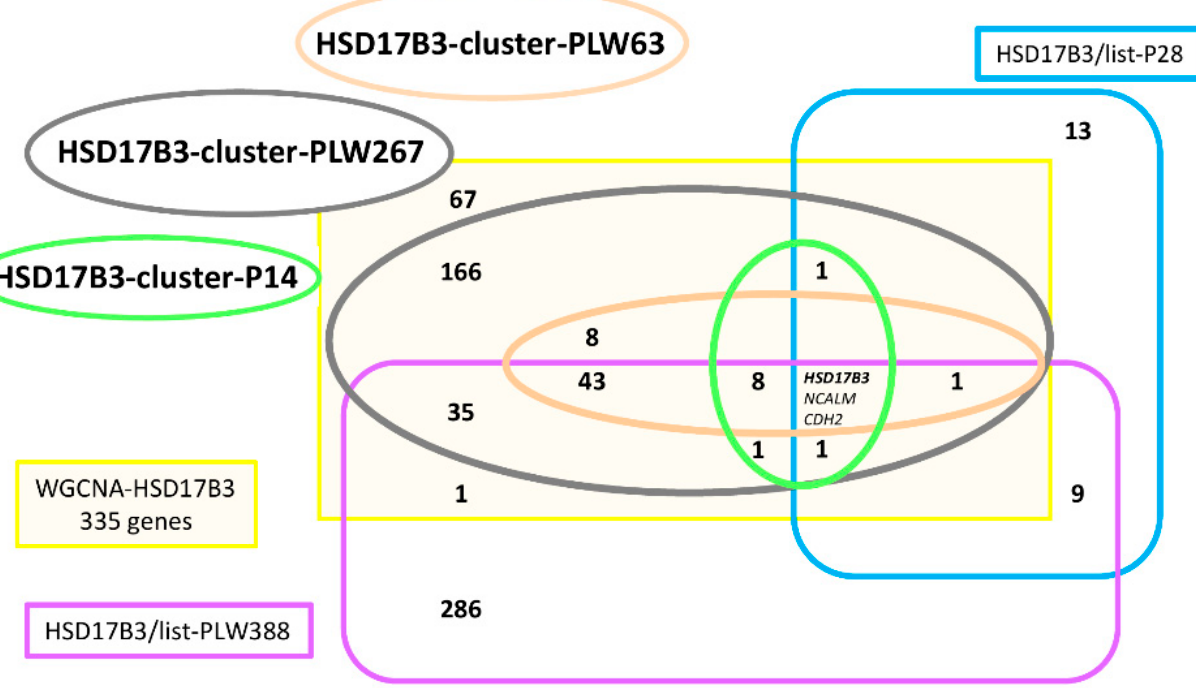
Figure 7. Characterization of the correlation group around HSD17B3. The analysis of HCAs led to defining HSD17B3- cluster-P14, HSD17B3-cluster-PLW63 and HSD17B3-cluster-PLW267 from WGCNA-HSD17B3. The list of genes strongly correlated to HSD17B3 in each mRNA-seq was established: HSD17B3/list-PLW388 and HSD17B3/list-P28. The comparison between these five elements was not favorable to the characterization of a large correlation group around HSD13B3.